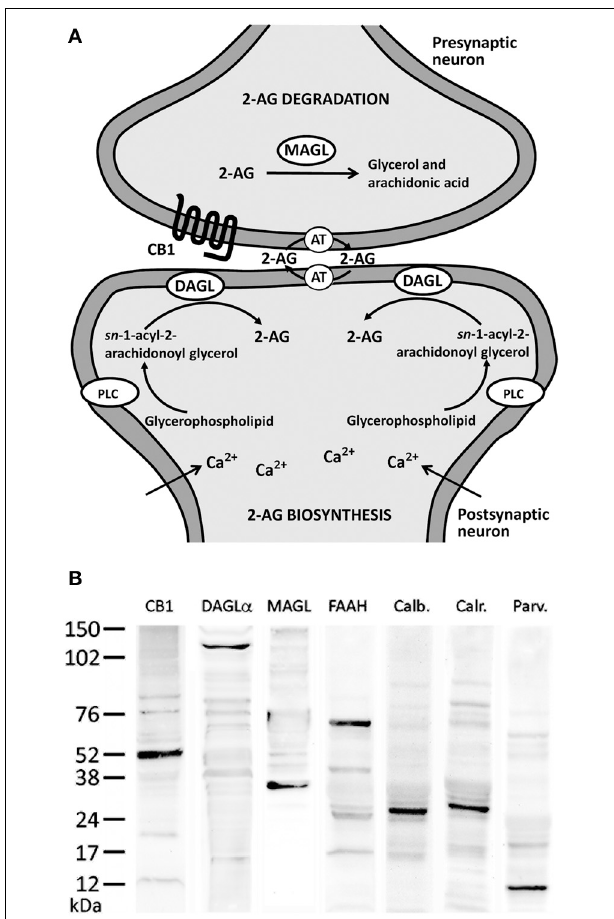
FIGURE 1 | (A) Major biochemical pathway for 2-AG signaling system. Postsynaptic calcium influx and the activation of metabolic receptors coupled to phosphotidyl-inositol-specific phospholipase C (PLC) and diacylglycerol lipase (DAGL) pathway lead to increases in 2-AG production. 2-AG signaling includes uptake into cells mediated by an unknown transporter (AT) and hydrolysis by specific enzymatic systems, such as MAGL. (B) Western blots of protein extracts from rat hippocampus showing CB 1 immunostaining as a prominent band at about 52kDa. Immunoblots for DAGL α , MAGL, and FAAH also revealed a single band with molecular masses of 120, 35, and 63kDa, respectively. Analysis of calbindin D28k, calretinin, and parvalbumin immunoblottings confirmed expected bands of 28, 29, and 10kDa,